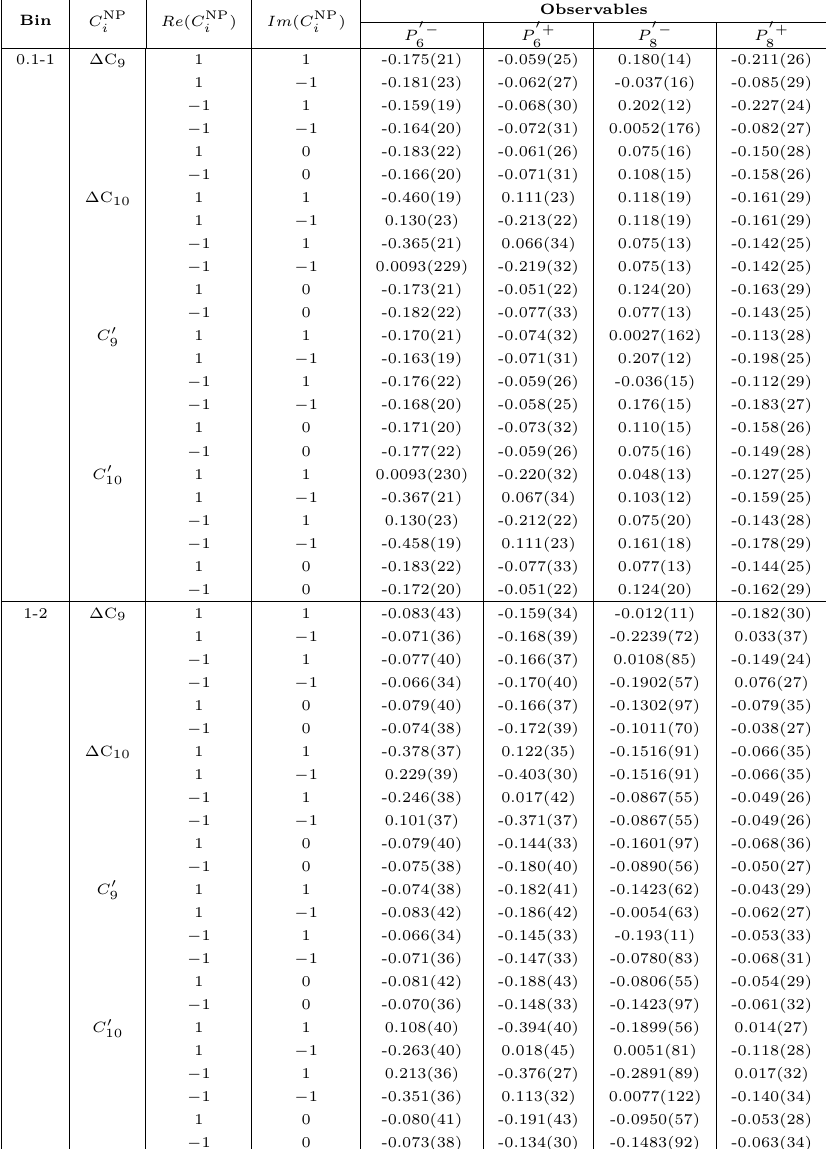
Table 30 . The dependence of some of the optimized observables corresponding to B + → ρ + ll and B − → ρ − ll on the real and imaginary parts of the NP WC’s ∆ C 9 , 10 and C 0 and 1 − 2 GeV 2 for a few benchmark values of the real and imaginary parts of the corresponding